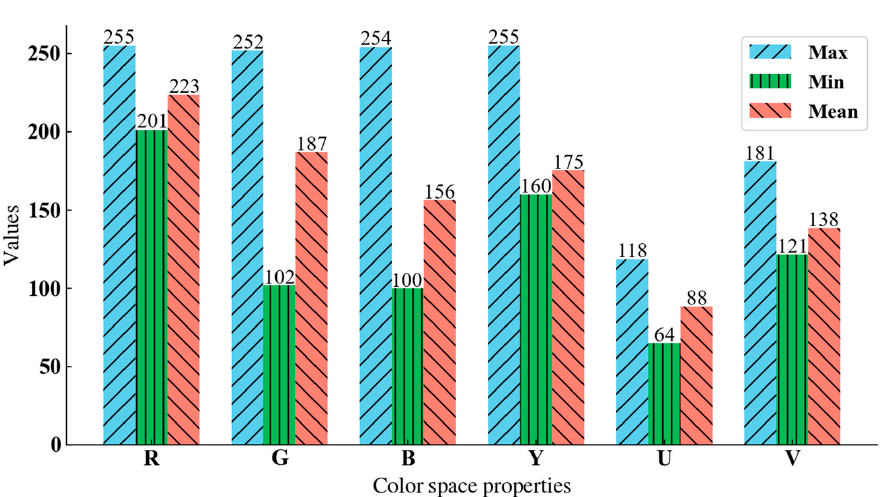
Figure 5. Comparison of the RGB and YUV attributes extracted from the point clouds of oil tea fruit.